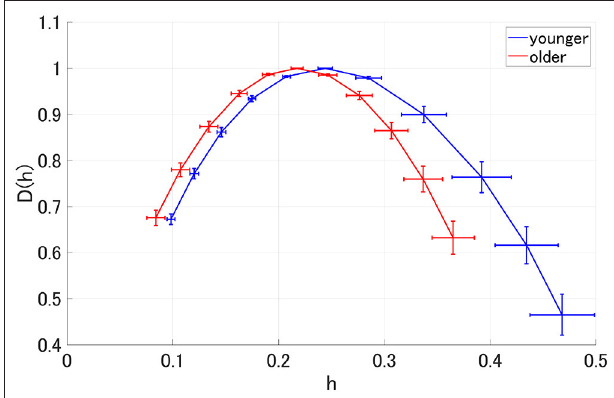
TABLE 1 | Younger vs. older repeated measure ANOVA analysis results [ F value ( p value, partial η 2 )] in multifractal (MF) analysis. Group Group × nodes Degree of freedom ( ǫ ) c 1 F = 25.25 ( p < 0.001, η 2 = 0.345) F = 1.73 ( p = 0.13, η 2 = 0.035) 5.06 ( ǫ = 0.034) | c 2 | F = 22.23 ( p < 0.001, η 2 = 0.317) F = 1.73 ( p = 0.11, η 2 = 0.035) 6.04 ( ǫ = 0.035) F and p values with p < 0.05 are represented by bold characters. Degree of freedom and Greenhouse-Geisser adjustments ǫ in the interaction for group × nodes are also shown.